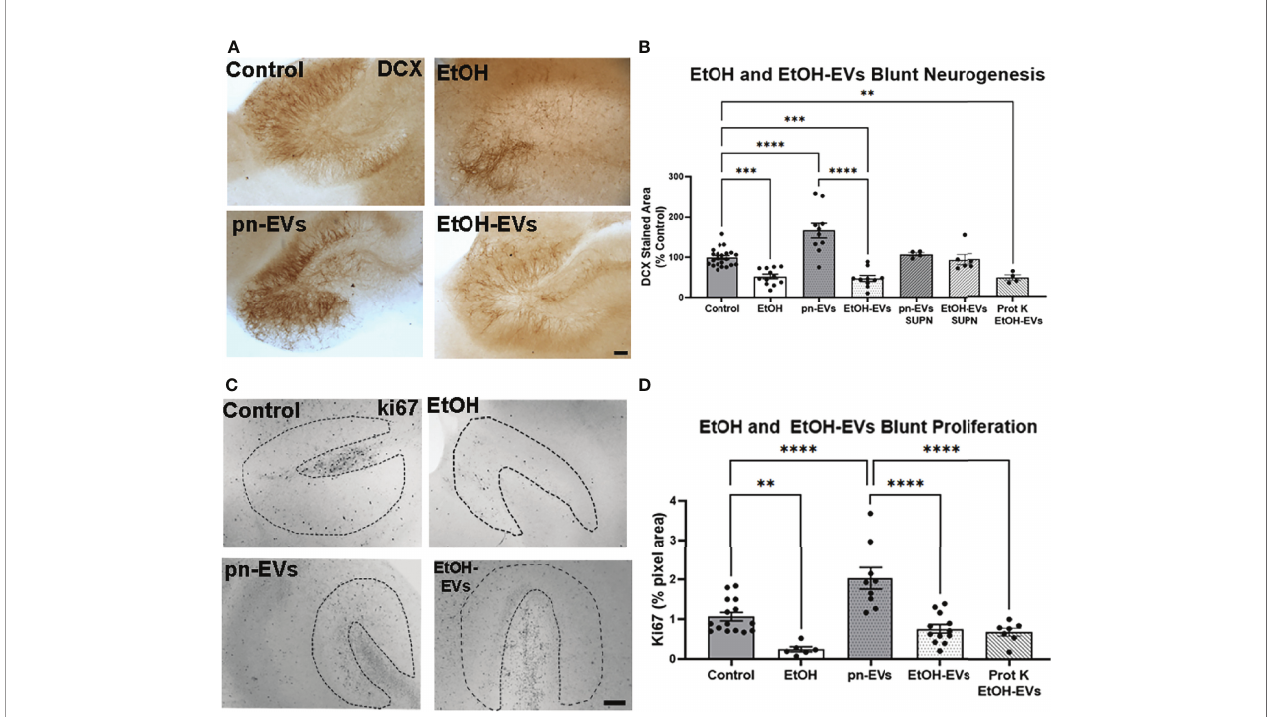
FIGURE 4 | EVs secreted by ethanol blunt neurogenesis. OBSCs were treated for 4 days with either vehicle, ethanol, pn-EVs, EtOH-EVs, supernatant (SUPN) from EV preparations, or EtOH-EVs treated with proteinase K (Prot K) to degrade free proteins. Neurogenesis measured by IHC for DCX. (A) Representative images showing enhancement of neurogenesis by pn-EVs and a clear reduction of neurogenesis by EtOH and EtOH-EVs. Scale bar 100 µm. (B) Quanti fi cation of DCX staining found a signi fi cant main effect of treatment (F 5, 58 = 20.9, p < 0.0001). A 48% reduction in DCX was caused by EtOH, a 67% increase by pn-EVs relative to control. EtOH-EVs caused a 52% reduction compared to pn-EVs. SUPN isolated from pn-EV and EtOH-EV preparations had no effect on DCX. Prot K digestion offree proteins had no effect on reduction of DCX caused by EtOH-EVs. (C) Representative images of ki67 immunostaining in OBSC in control, EtOH, control/pn-EVs and EtOH-EVs. The neurogenic niche in the OBSC is outlined by the dashed lines. (D) Quanti fi cation of ki67 found a main effect of treatment (one-way ANOVA, F 3,41 = 21.75, p < 0.0001.) Ethanol-EVs caused a 45% reduction in 60% reduction in ki67 staining compared to pn-EVs. Prot K digestion free proteins had no impack on loss of Ki67 caused by EtOH-EVs.** p < 0.01, *** p < 0.001, **** p < 0.00001 Sidak ’ s post-test. Each dot represents an individual culture